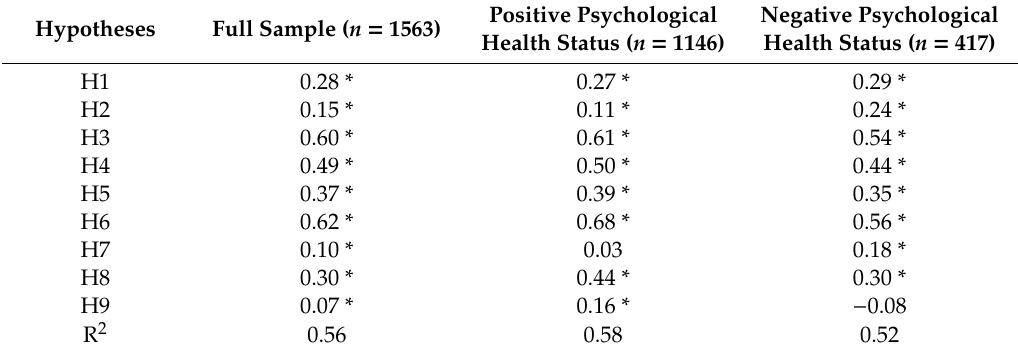
Table 4. Hypotheses tests.